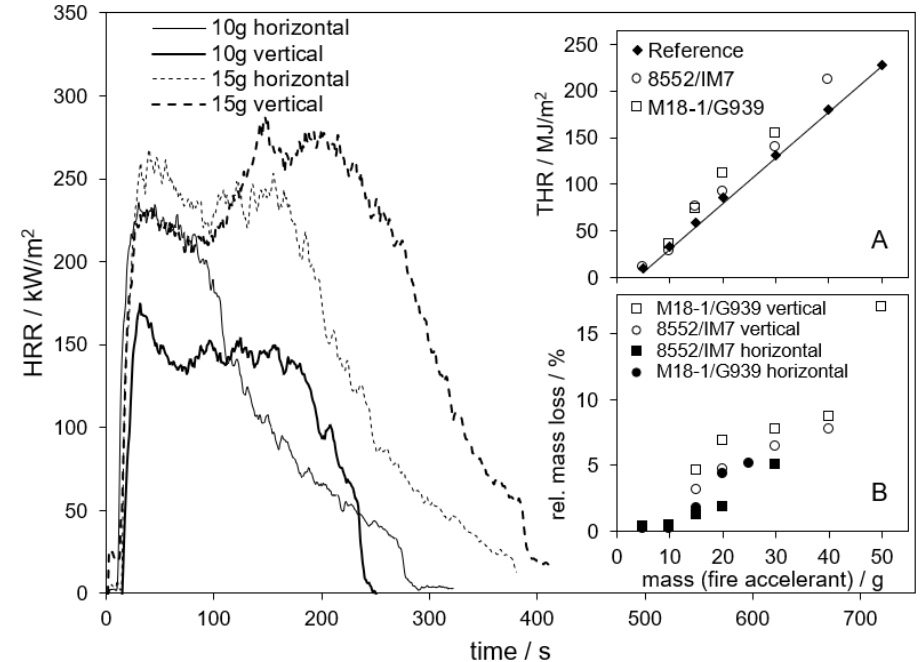
Figure 14. Heat release rates (HRR) and total heat release (THR, inset A) for 2 mm thick horizontally and vertically aligned 8552/IM7 samples as well as mass loss (inset B) for various amounts of fire accelerants. Line in inset A corresponds to the reference material without CFRP (steel panel). (HRR curves of reference measurements correspond to those of horizontally aligned CFRP panels).